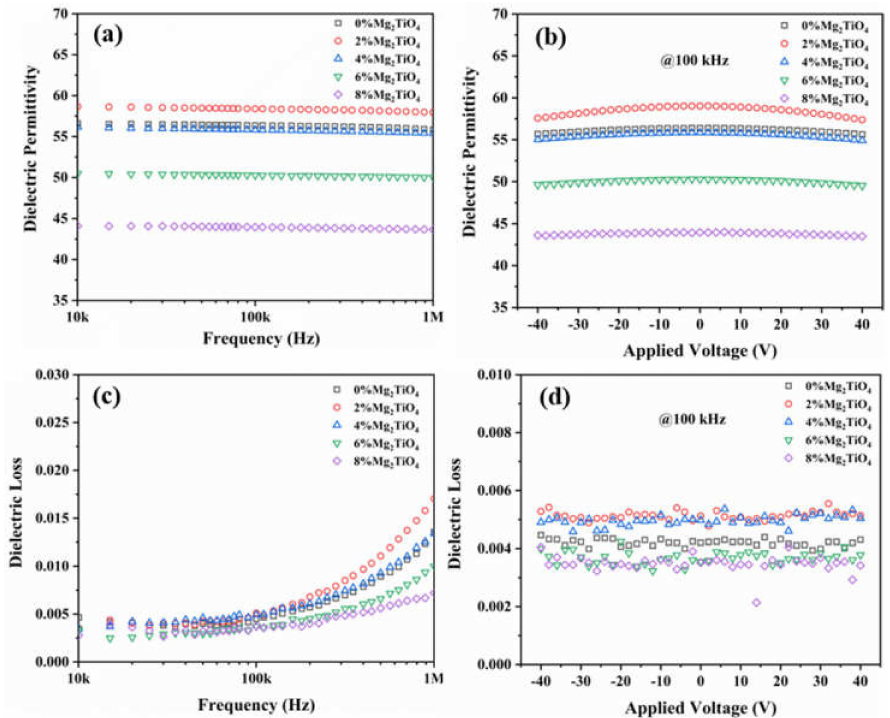
Figure 3. The dielectric properties of the prepared thin films at room temperature. ( a , b ) are the dielectric permittivity of x% Mg 2 TiO 4 -CSZT thin films as a function of frequency and DC voltage, respectively; ( c , d ) are the dielectric loss of x% Mg 2 TiO 4 -CSZT thin films as a function of frequency and DC voltage,